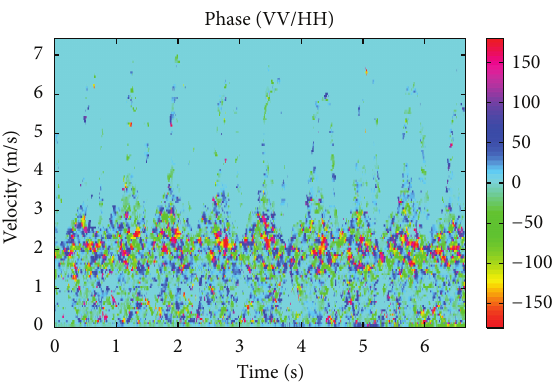
Figure4:Polarimetricmeasurementofahumanwalkingawayfrom the radar at Ka band. The black double-bounce areas correspond to the elbow motion, while the white and grey single-bounce area is the rest of the body.